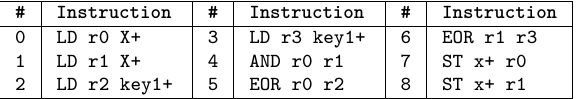
Table 2: Assembly implementation F ex for example